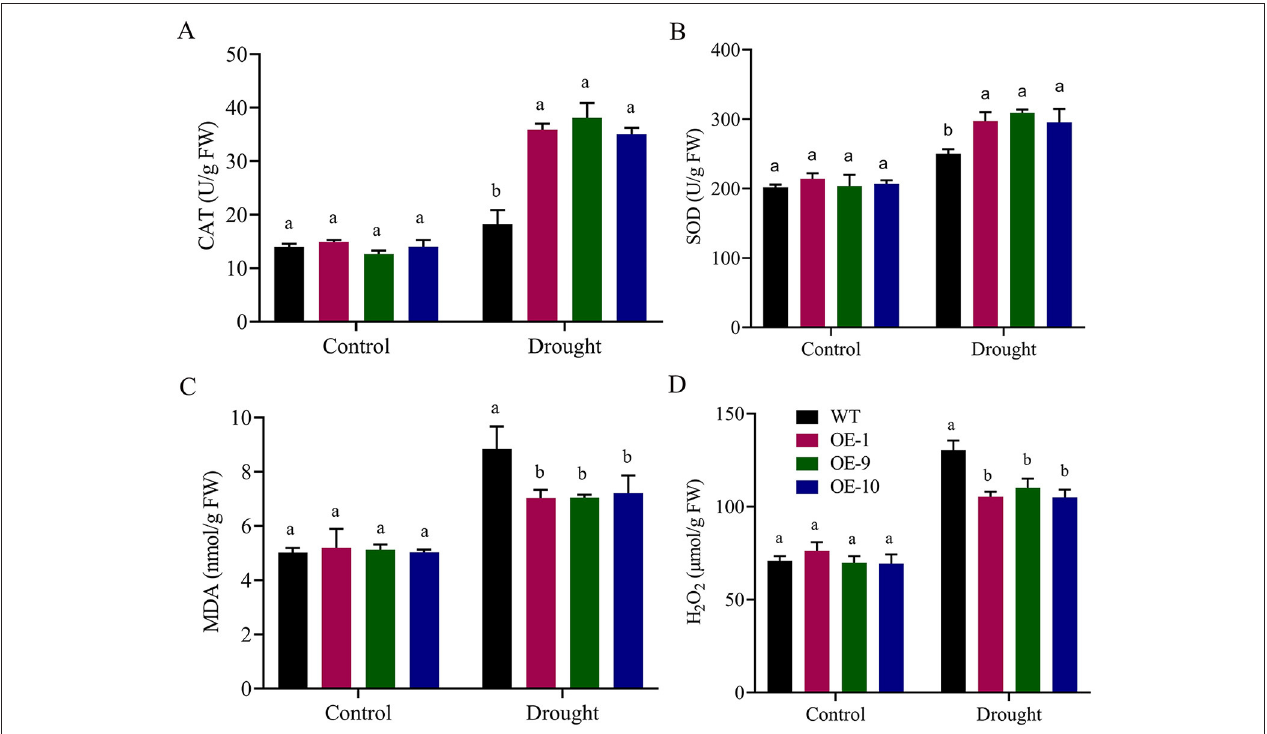
FIGURE 7 | Evaluation of Antioxidants and oxidants in ALDH overexpressed and WT during drought stress (A) Catalase (CAT), (B) Superoxidase (SOD), (C) Malondialdehyde (MDA), (D) Hydrogen peroxide (H 2 O 2 ) in post-treatment. Bars indicate SE. Three replications were maintained in the experiment. WT, wild type; OE-1, OE-9, OE-10, overexpressed lines. CAT, catalase; SOD, superoxidase; MDA, malondialdehyde; ALDH, Aldehyde dehydrogenase.